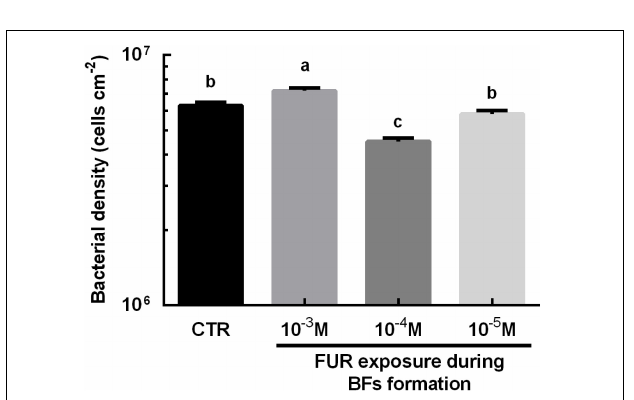
FIGURE 2 | Bacterial densities of FUR-treated biofilms. The results are presented as the mean ± SEM of three biological samples, and each sample was calculated by 10 random fields of view. Control (CTR), P. marina ECSMB14103 biofilm prepared on a sterile glass slide without adding FUR. Significant differences ( p < 0.05) are represented by different letters above the